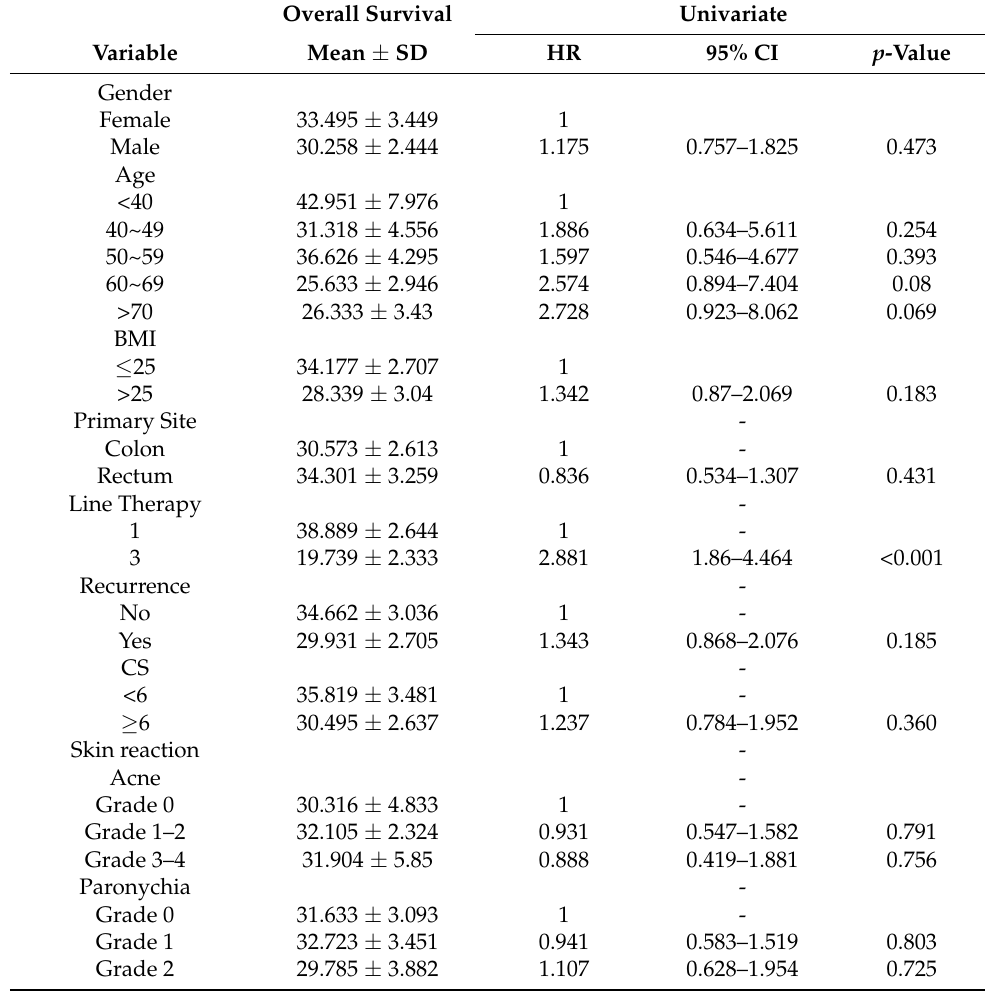
Table 4. Association of clinical variables and skin reactions with median overall survival by univariate analysis (N = 111).